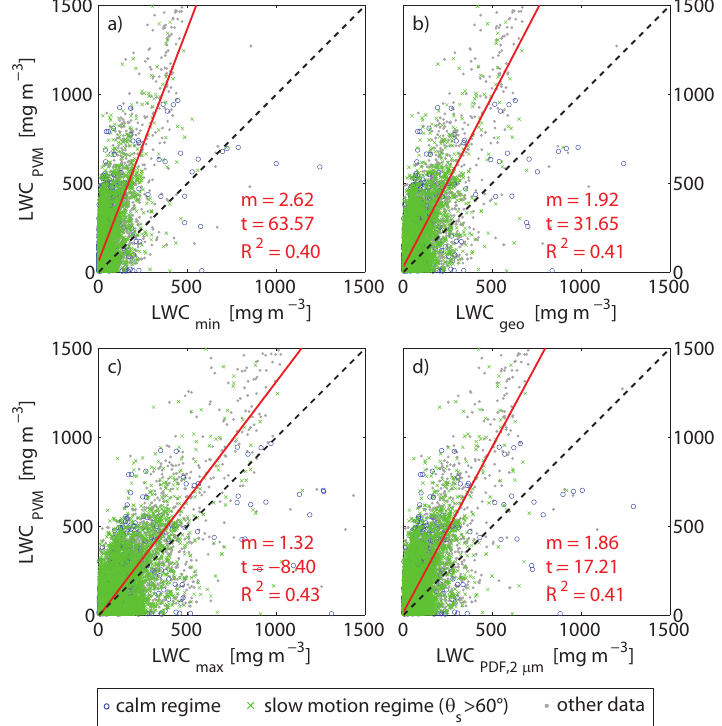
Fig. 10. Effect of the Mie corrections on the LWC during CLACE 2010 (blue circle: U 0 < 0.5ms − 1 ; green crosses: 0.5 <R v < 0.8 and θ s > 60 ◦ ; gray dots: rest of the data fulfilling the cloud criterion). (a) to (c) LWC measured by the PVM-100 (LWC PVM ) versus LWC deduced from the FM-100 measurements using the channel widening method (Sect. 3.1.1). (d) LWC PVM versus LWC deduced from the FM-100 measurements using the stochastic approach (Sect. 3.1.2). The solid red line represents a geometric mean regression to the entire data with m : slope, t : intercept and R 2 : squared correlation